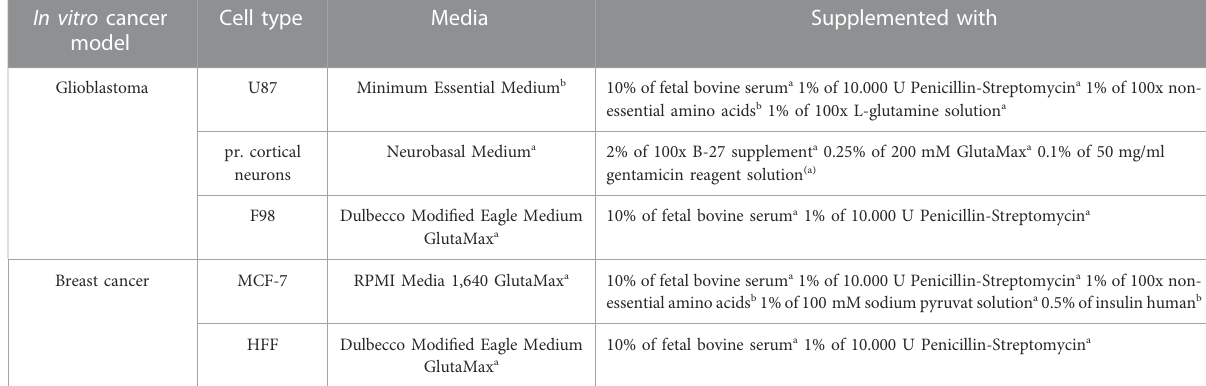
TABLE1Cellculturemediumforassessed celltypes.Allmediaandsupplements werepurchasedfromeitherThermoFischer a (UnitedStates)orSigmaAldrich (United States) b . In vitro cancer